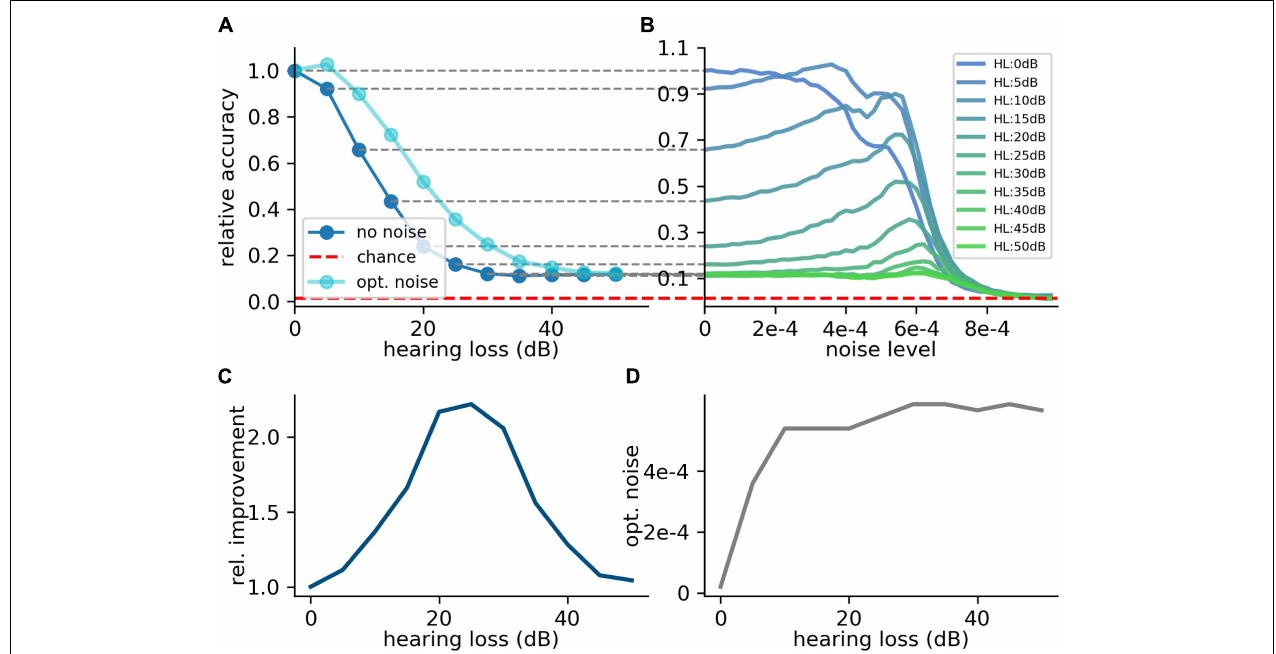
FIGURE 7 | Effect of SR on speech recognition. (A) The curve shows the relative accuracy of the trained neural network as a function of the hearing loss (red dashed line: chance level; ( 1 / 207 ) max accuracy ). The hearing loss (5–50 dB, 5 dB steps, frequency range of HL: 400 Hz–4,000 Hz) was implemented in the test data set and propagated through the pre-trained network. Thus, the cochlea output was multiplied with an attenuation factor (10 − HL 20 ). This output was then transformed using the integrate-and-fire neurons and fed in the neural network. (B) Relative accuracy as a function of the applied noise level for different hearing losses. Resonance curves with one global maximum at a certain noise level > 0 could be shown. (C) Best relative improvement as a function of the hearing loss. (D) Optimal noise level as a function of the hearing